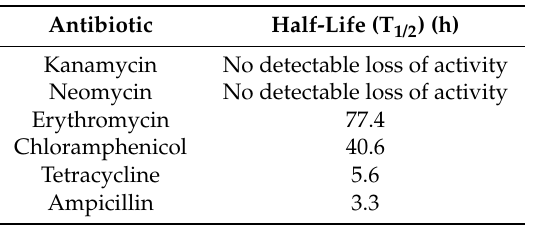
Table 5. Half-lives of selected antibiotics incubated in anaerobic medium, 72 ◦ C and pH 7.3 (adapted from Peteranderl et al., 1990